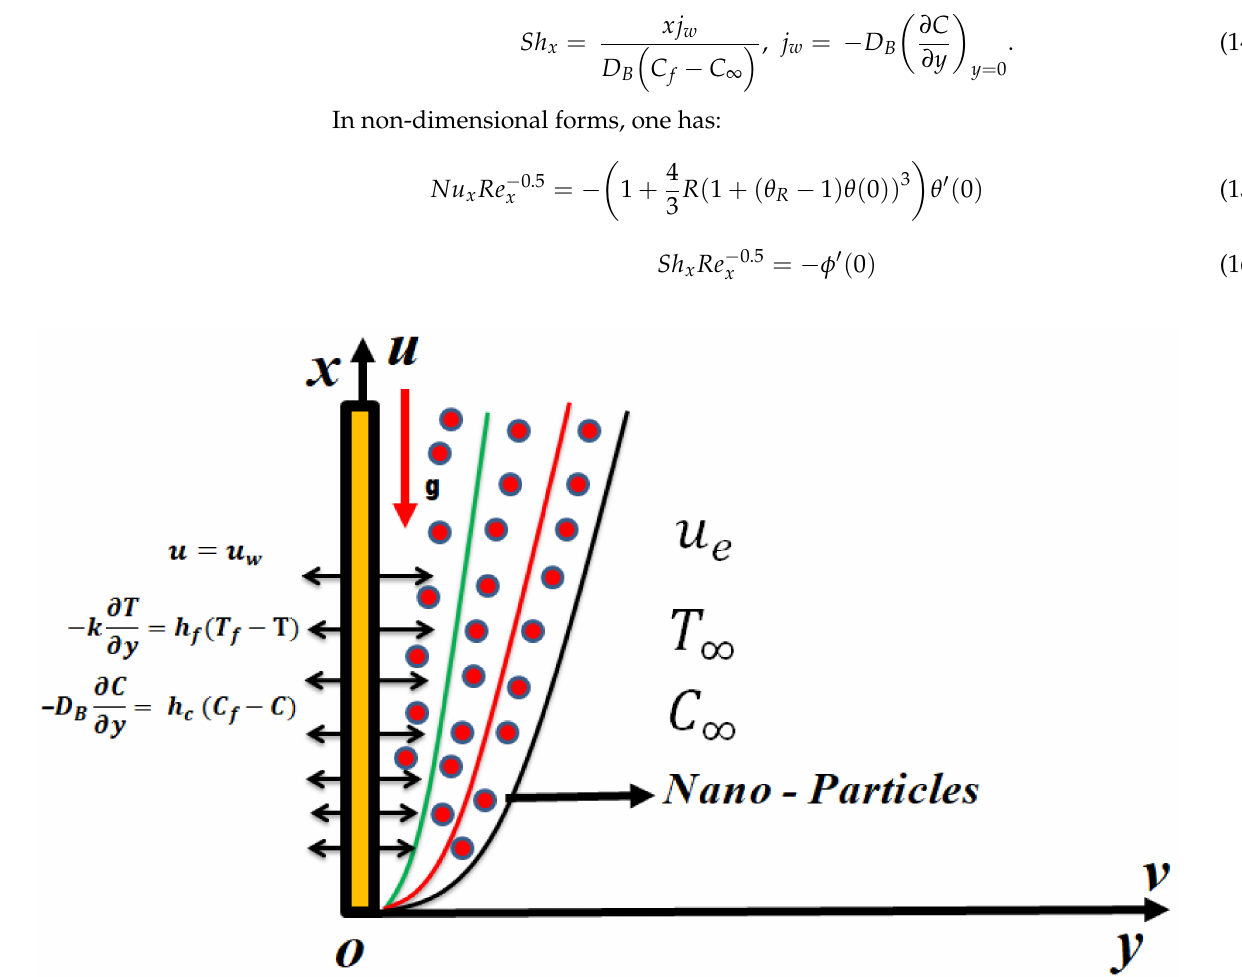
Figure 1. Flow model of Oldroyd-B